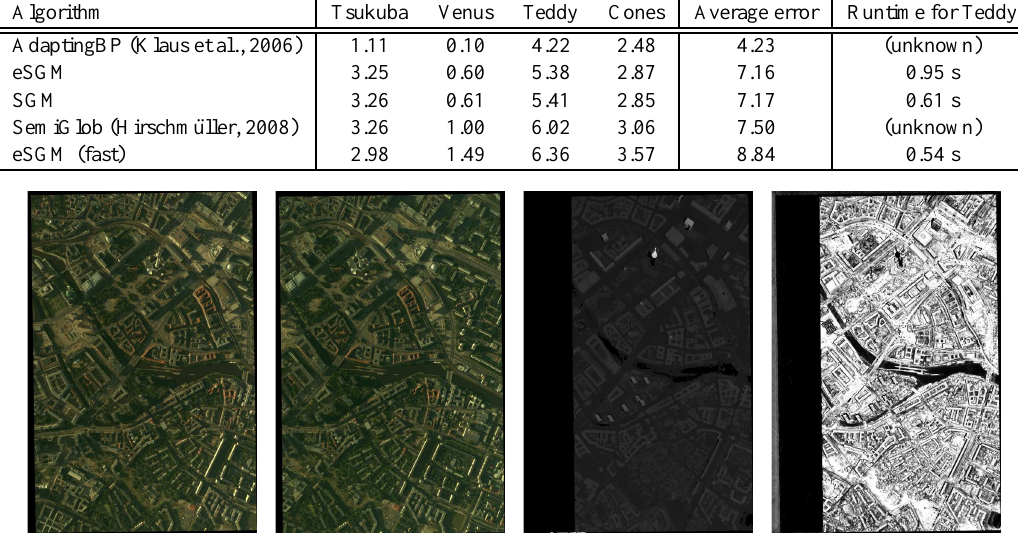
Table 1: Errors in non-occluded areas of the Middlebury datasets using the standard threshold of one pixel.